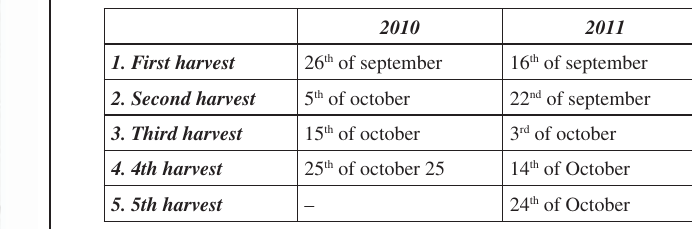
Table 1: Dates of the samplings (harvests) in both examined years